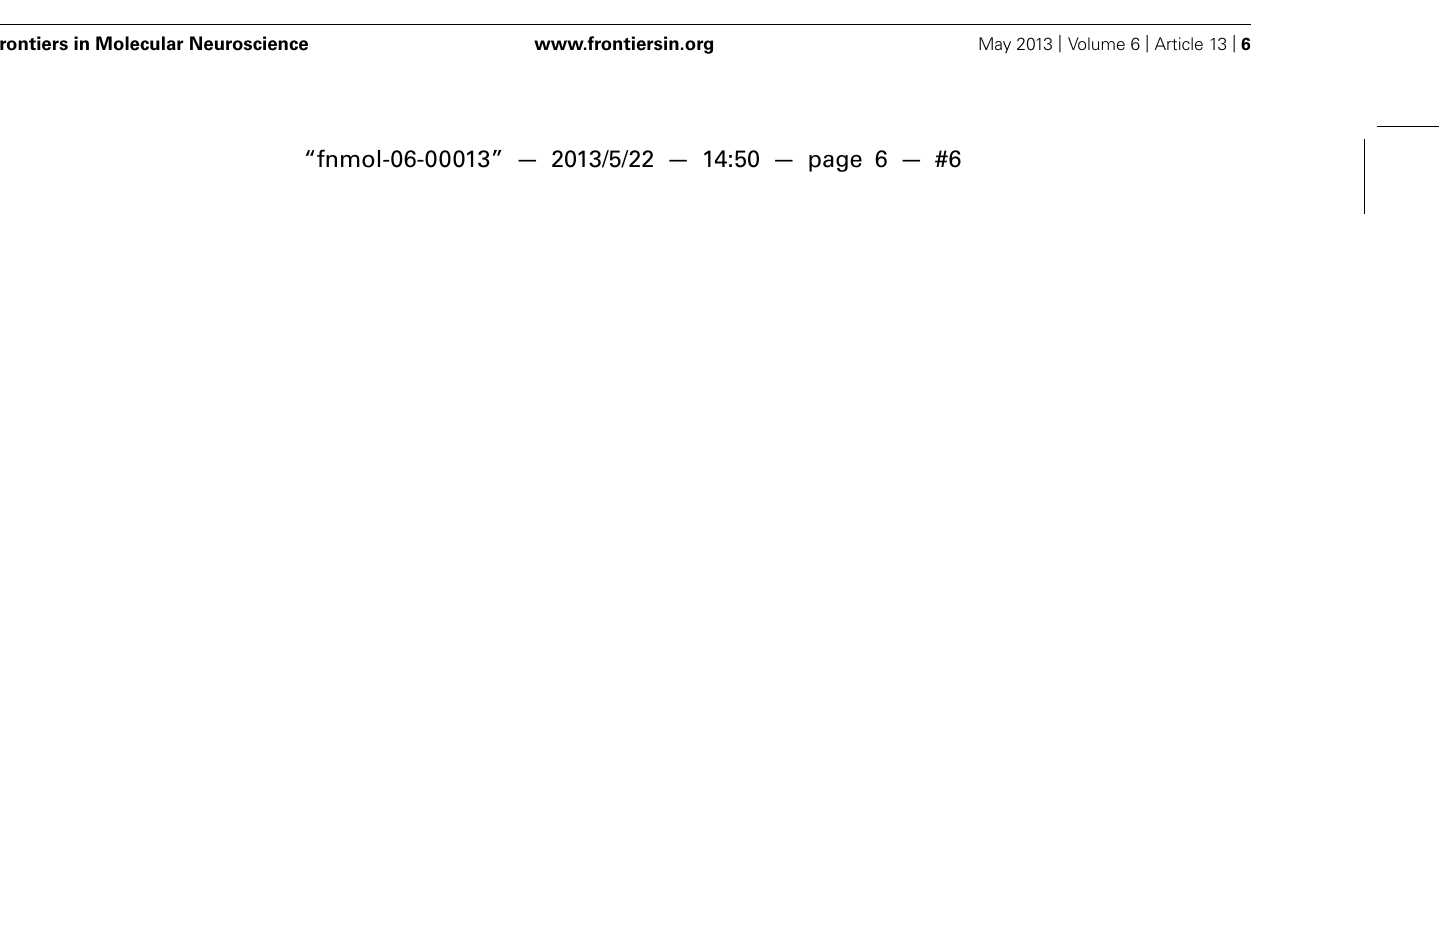
green (532 nm) light illumination in NAc D1-MSNs expressing eNpHR3.0. (E) 5-day, 60-min per day green light illumination (paradigm used in Figure 4 ) to the NAc does not alter cell death markers or NeuN gene expression in D1-Cre NAc expressing AAV-DIO-eNpHR3.0-EYFP or AAV-DIO-EYFP (Student’s t -test, p >